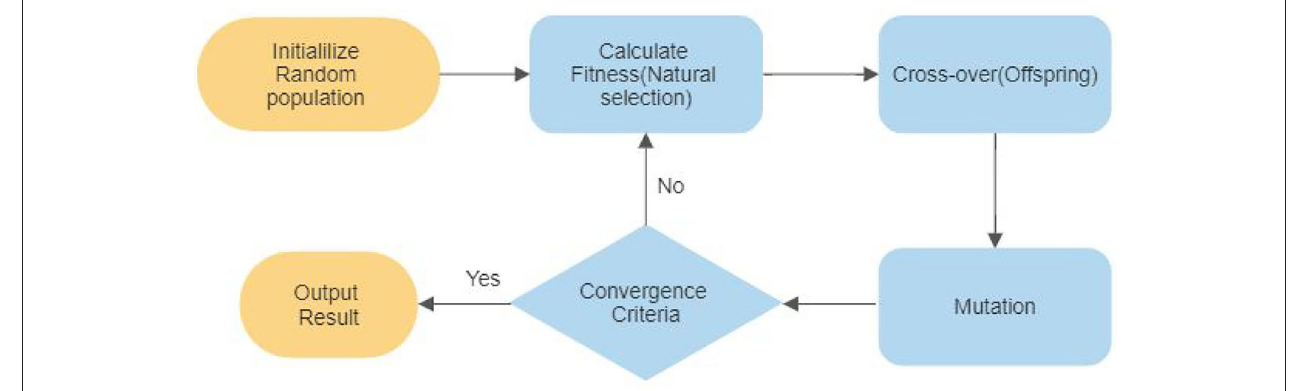
FIGURE 7 | Genetic algorithm process